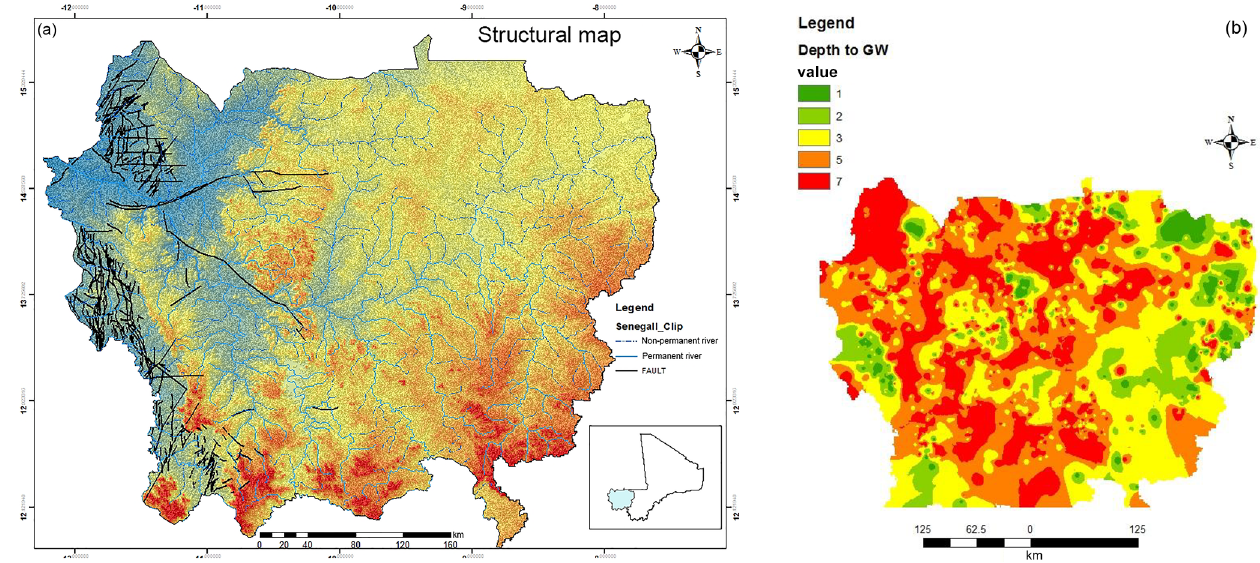
Figure 1. (a) Study area location and hydrogeological map. (b) Groundwater (GW) depth distribution map.